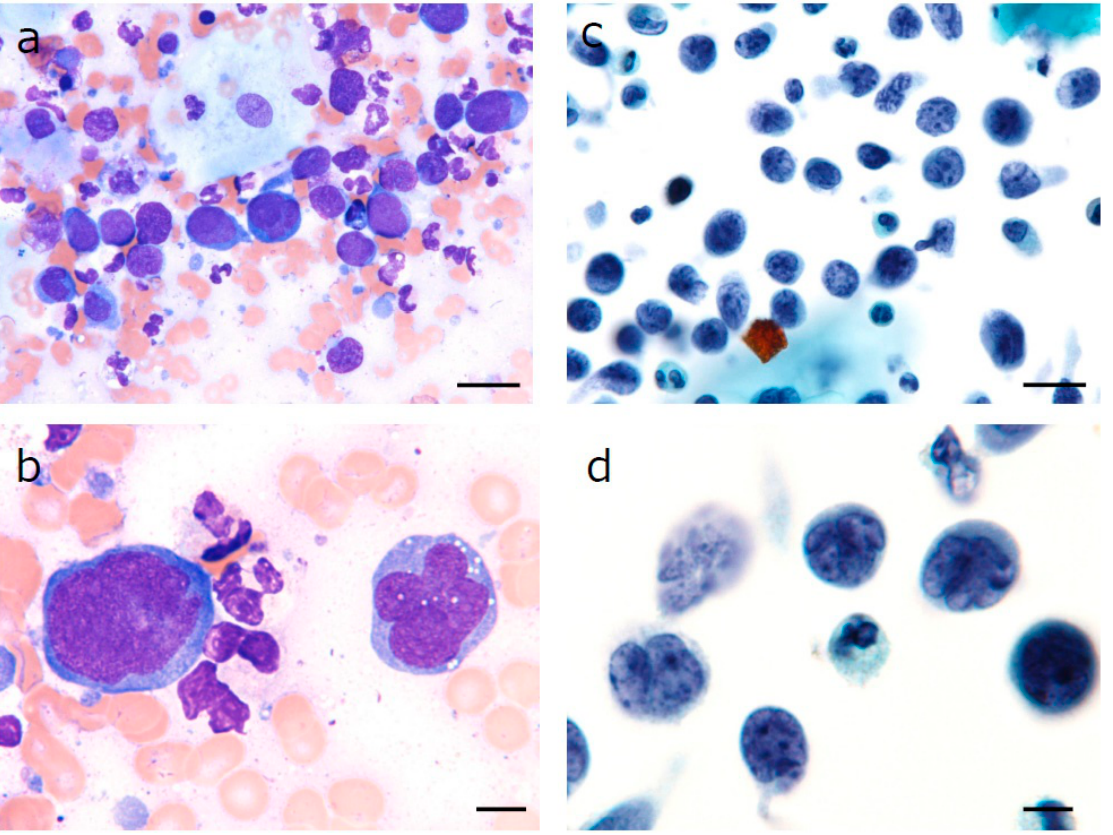
Figure 2. Microscopic view of oral specimens harvested from suspicious lesions. Large atypical lymphocytes with an irregular nuclear shape (Giemsa staining, ( a ) magnification 40×, bar = 20µm ( b ) magnification 100×, bar = 5µm). In the liquid-based cytology (LBC) specimen, ( c ) large atypical lymphocytes with a high nuclear/cytoplasmic ratio were recognized with prominent nucleoli (Papanicolou staining, magnification 40×, bar = 20µm); ( d ) The nuclear strips implied nuclear fragility (Papanicolou staining, magnification 100×, bar = 5µm).